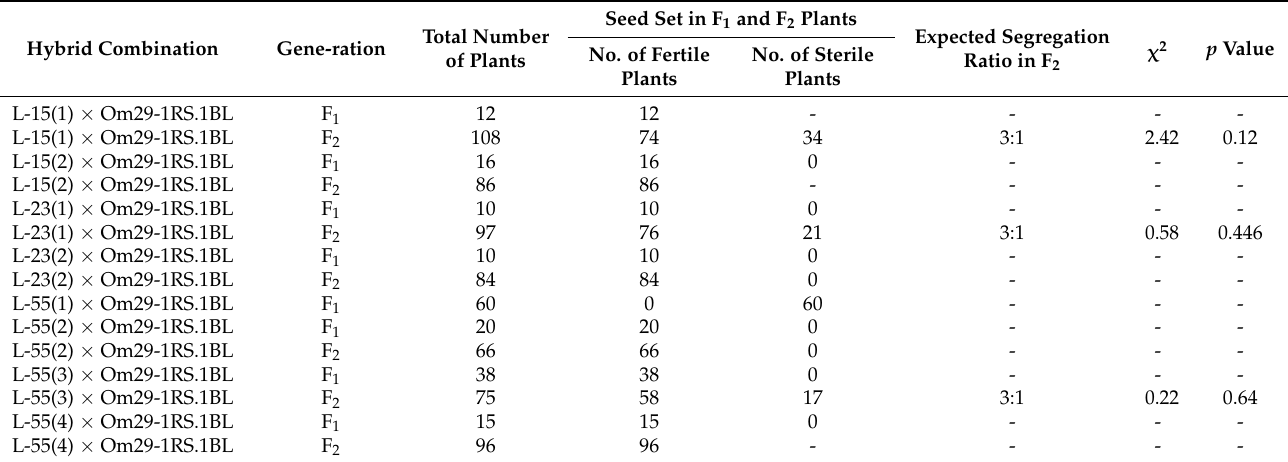
Seed Set in F 1 and F 2 Plants Total Number Expected Segregation 2 p ValueNo. of Fertile No. of Sterile of Plants Ratio in F 2 χ Plants Plants